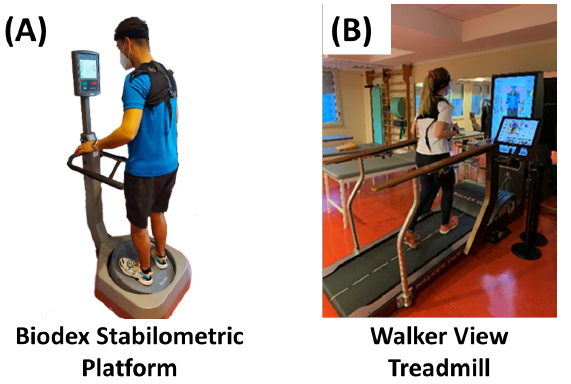
Figure 3. Platform used in the experiments. ( A ) The Biodex stabilometric platform is used to simulate a fall event. ( B ) The Walker View treadmill is used to physically exert the